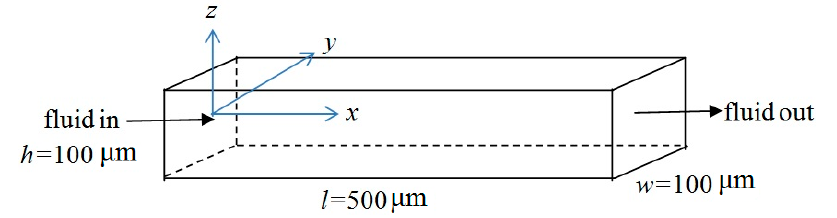
Figure 2. Schematics of the rectangular channel problem used to compare the quasi-3D model with the analytical solution. The midpoint of the channel inlet is taken as the origin of the coordinate system.